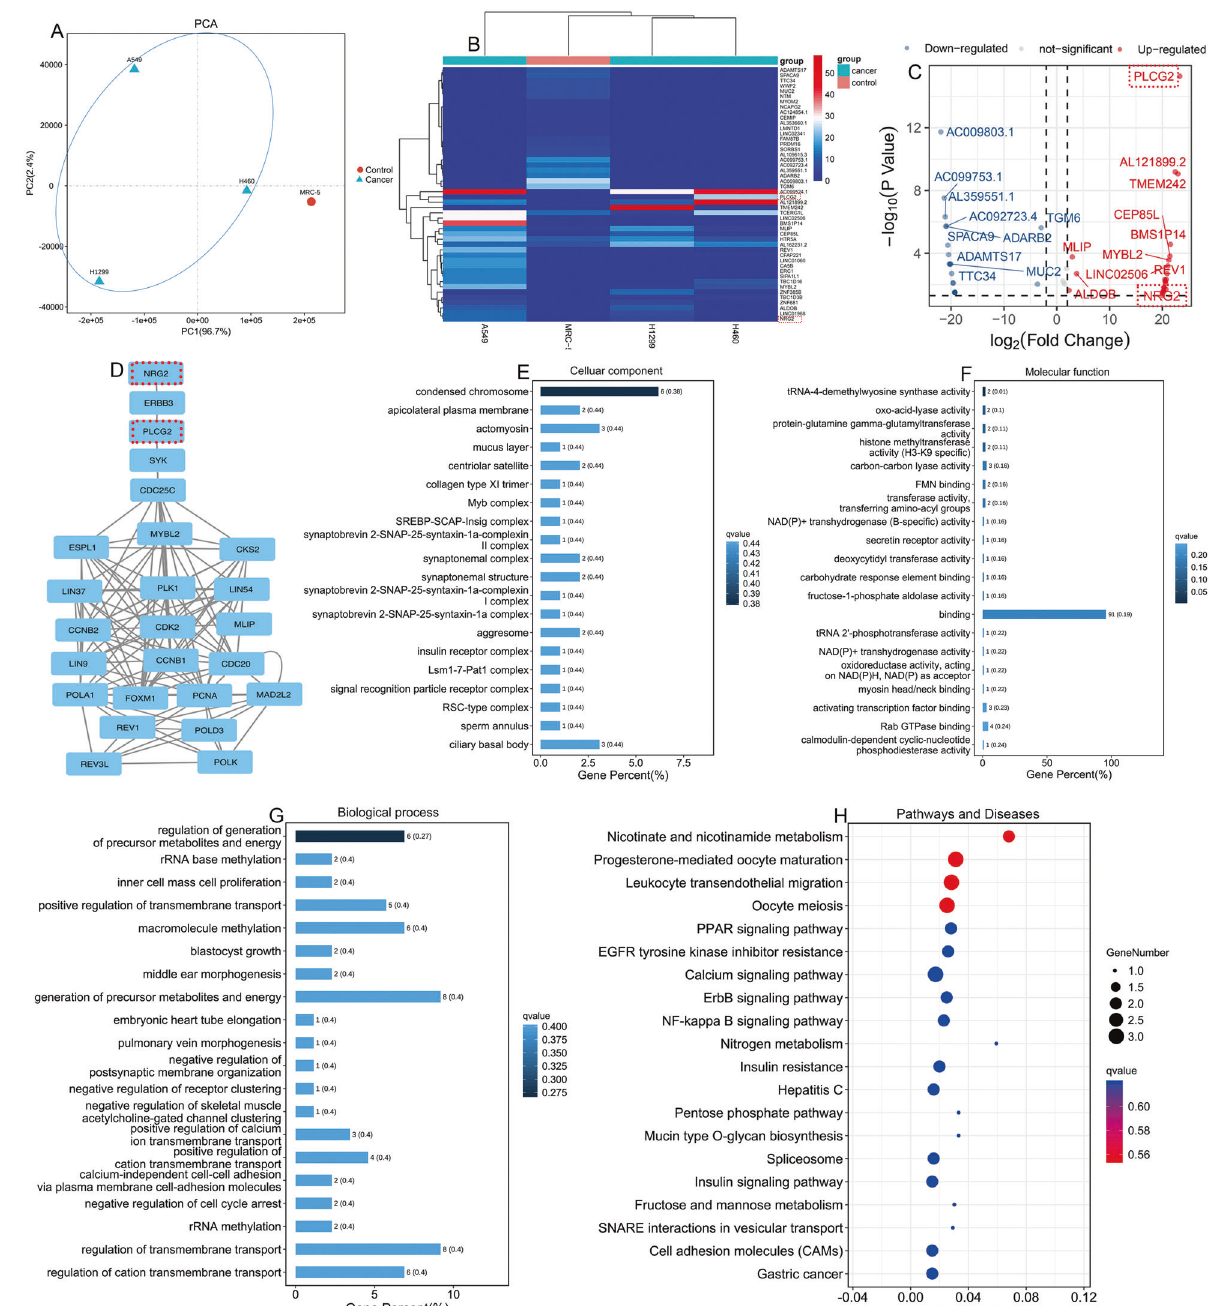
Fig. 3 Identi fi cation of the differentially expressed eccDNAs and genes between NSCLC cells and normal cells. A PCA of NSCLC cells and normal cells according to differences in eccDNA-related genes. B , C Cluster and scatter plots showing the differentially expressed eccDNA- related genes between NSCLC cells and normal cells. D PPI analysis of the major differentially expressed eccDNA-derived genes from STRING (https://string-db.org/). E – G The cellular components, molecular functions, and biological processes associated with the differentiated eccDNA-related genes. H KEGG pathway analysis of the eccDNA-related genes between NSCLC and normal lung cells. EccDNA extrachromosomal circular DNA, NSCLC non-small cell lung cancer. Identi fi cation of differentially expressed eccDNAs and enriched in mitochondrial function, binding and immune response enrichment analysis of the eccDNAs encoding ampli fi ed genes (Fig. 2J – L). KEGG pathway analysis revealed that the genes between NSCLC and normal lung cells associated with eccDNAs were mainly involved in leukocyte Principal component analysis (PCA) between NSCLC cells and transendothelial migration and the nitrogen metabolism pathway normal lung cells showed that NSCLC cells could be distinguished (Fig. 2M). These results indicated that the chromosome distribution, from normal lung cells based on eccDNAs (Fig. 3A). According to length distribution, and genomic annotation of the eccDNAs were the screening criteria ( P value < 0.05 and |LogFC| > 2), differentially comparable between the NSCLC and normal groups.